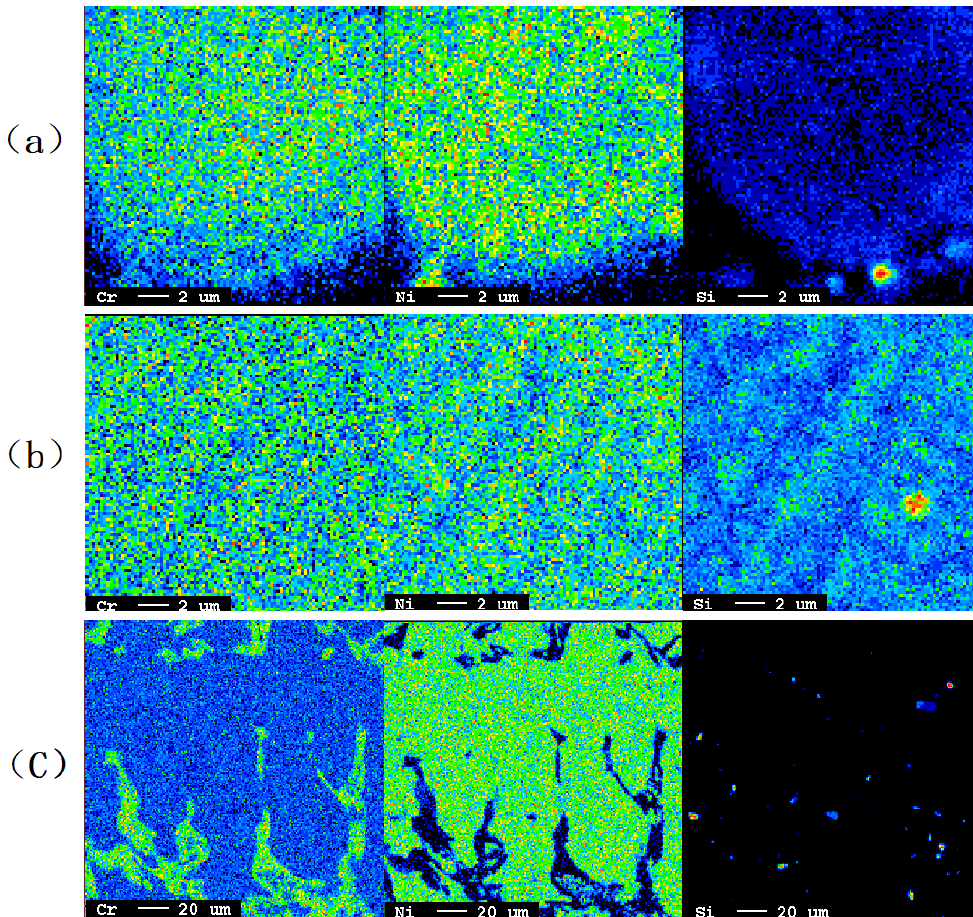
Figure 11. Distribution of elements: ( a ) powder with a diameter of 19 μ m; ( b ) secondary dendrite in a powder with a diameter of 104 μ m; ( c ) secondary dendrite in an ingot.